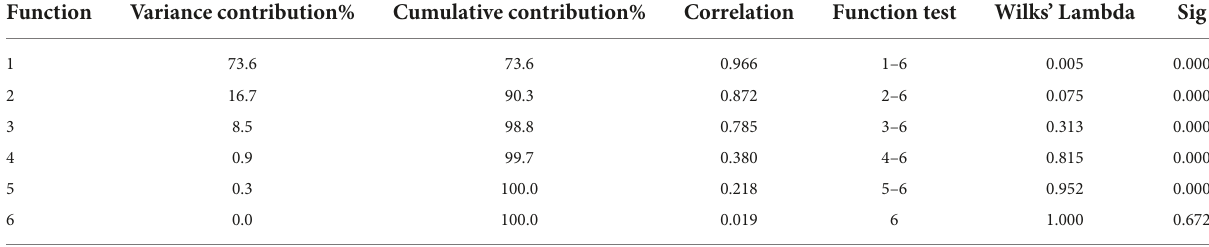
TABLE 7 Summary of Fisher’s discriminant functions.